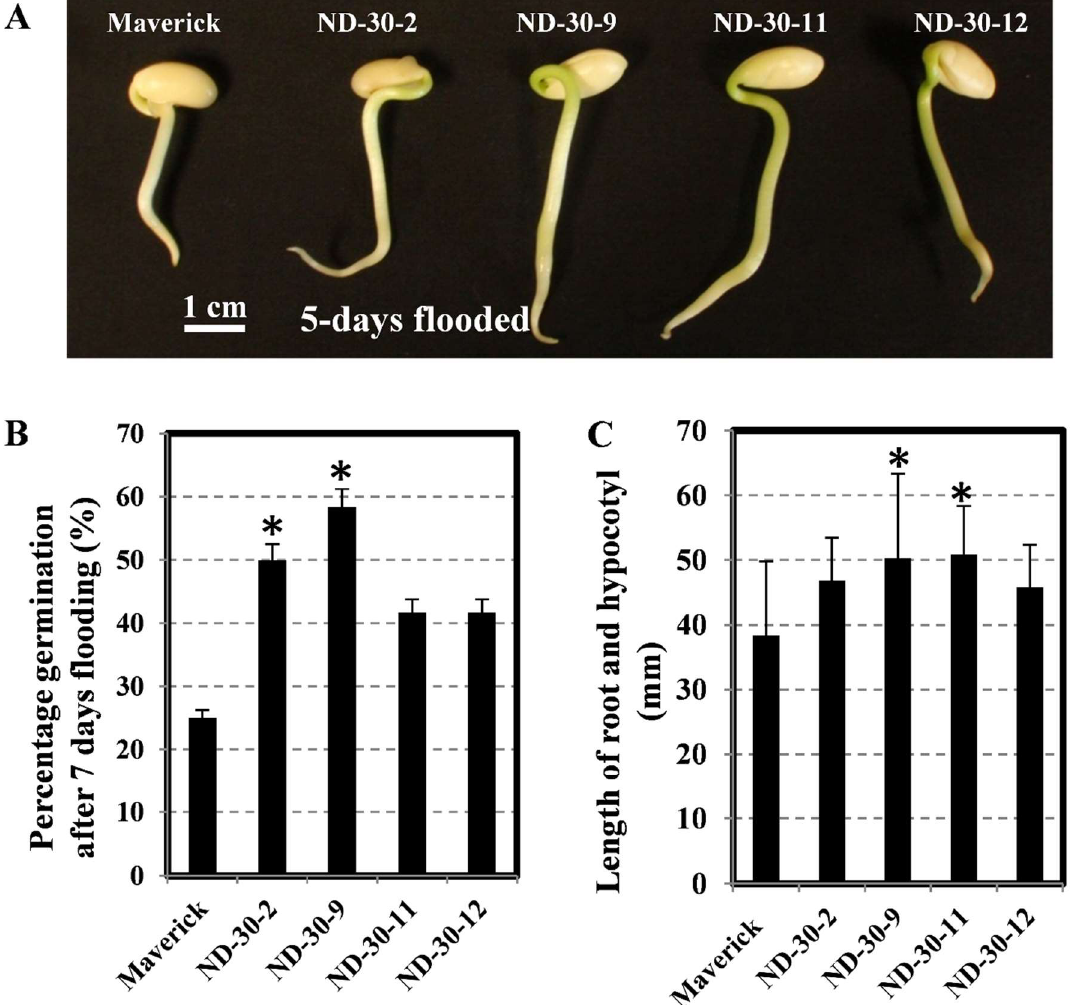
Figure 7. Soybean AtXTH31 transgenic plants show an enhanced germination ratio and elongated root and hypocotyl under flooding conditions. ( A ) Two-day-old seedlings were flooded with water for 5 days. Bar indicates 1 cm. ( B ) The germination rate of transgenic and wild-type plants under 7 days of flooding. ( C ) Length of roots and hypocotyls of flooded Maverick soybean and transgenic seedlings. ( n ≥ 30). * indicates differences between the maverick and transgenic soybean ( p < 0.05).